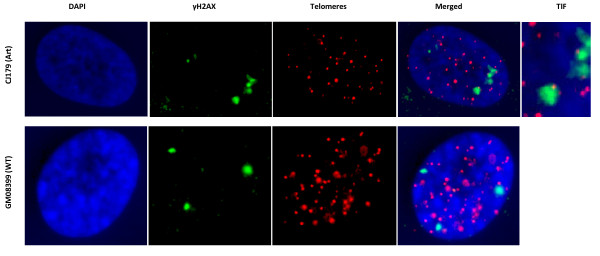
Representative examples of cell nuclei with or without TIFs. Upper panel: a cell nucleus showing a TIF. Lower panel: a cell nucleus with separate γ-H2AX and telomere signals (no TIF).